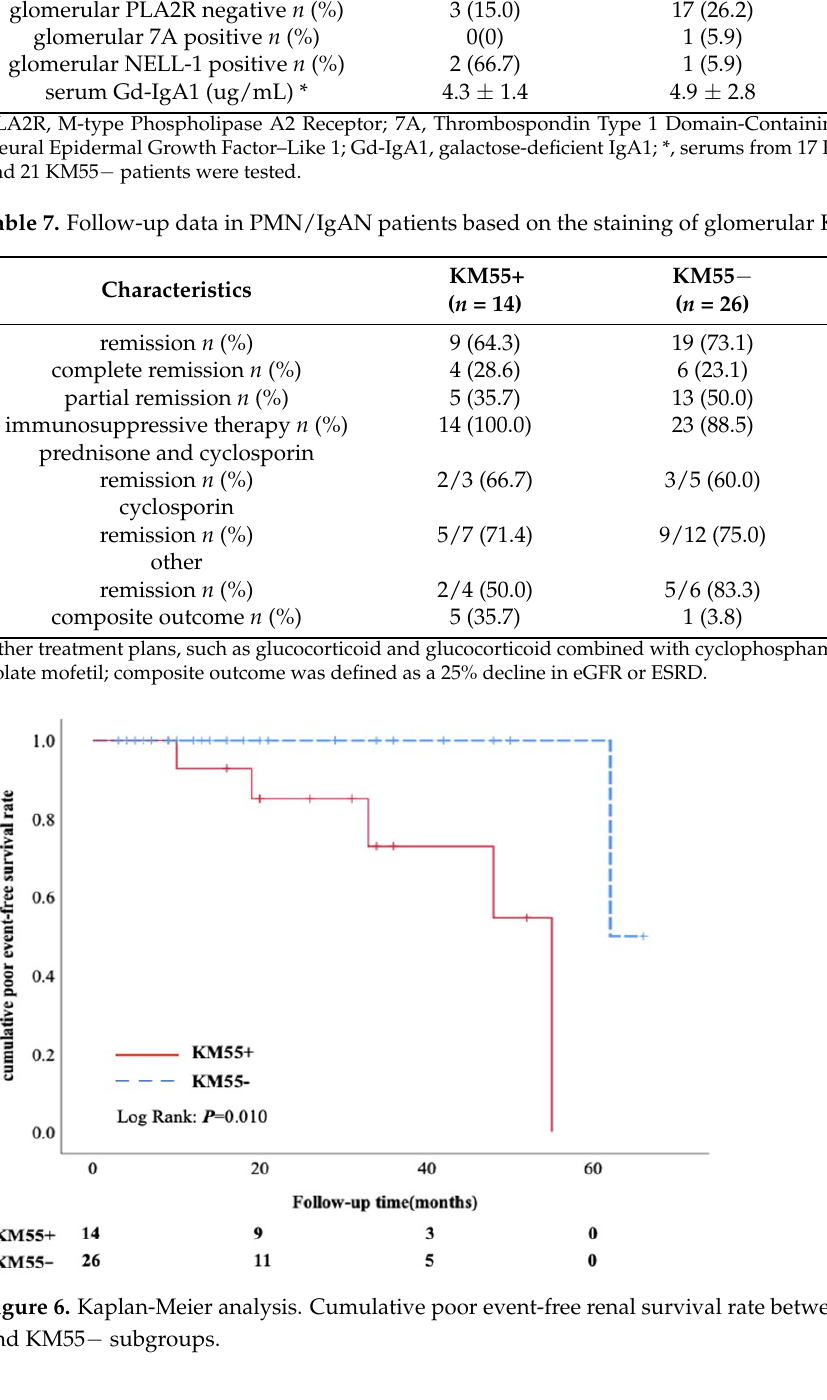
Table 6. Disease-specific pathogenic biomarkers in PMN/IgAN patients based on the staining of glomerular KM55. Characteristics